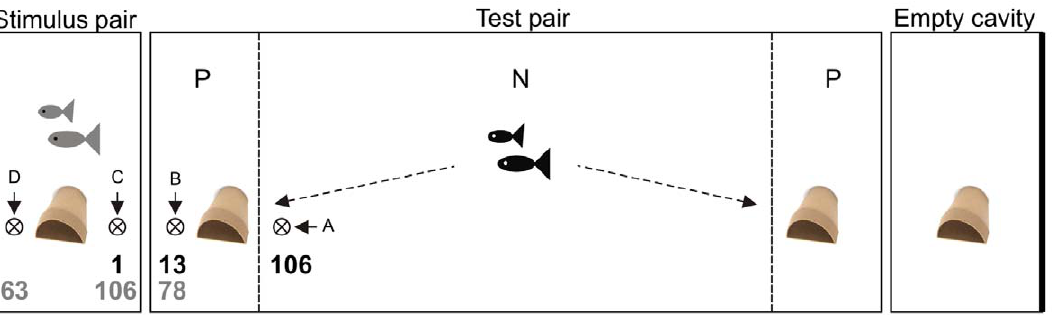
Figure 1. The experimental set-up. One large central tank for the test pair and two adjacent small tanks comprised the experimental set-up. The two small tanks each contained a potential breeding cavity (flower pot), one occupied by a stimulus pair and the other unoccupied. The large central tank contained two potential breeding cavities and a test pair. A, B, C and D indicate the two neighbor (B, C) and two non-neighbor (A, D) predator presentation sites. To assess the location of the test pair we divided the central aquarium into two preference zones (P) and one neutral zone (N). The numbers below the presentation sites are the median attack rates of the pairs at the respective location. Gray numbers are the anti-predator attack rates by the stimulus pair and black numbers are the attack rates by the test